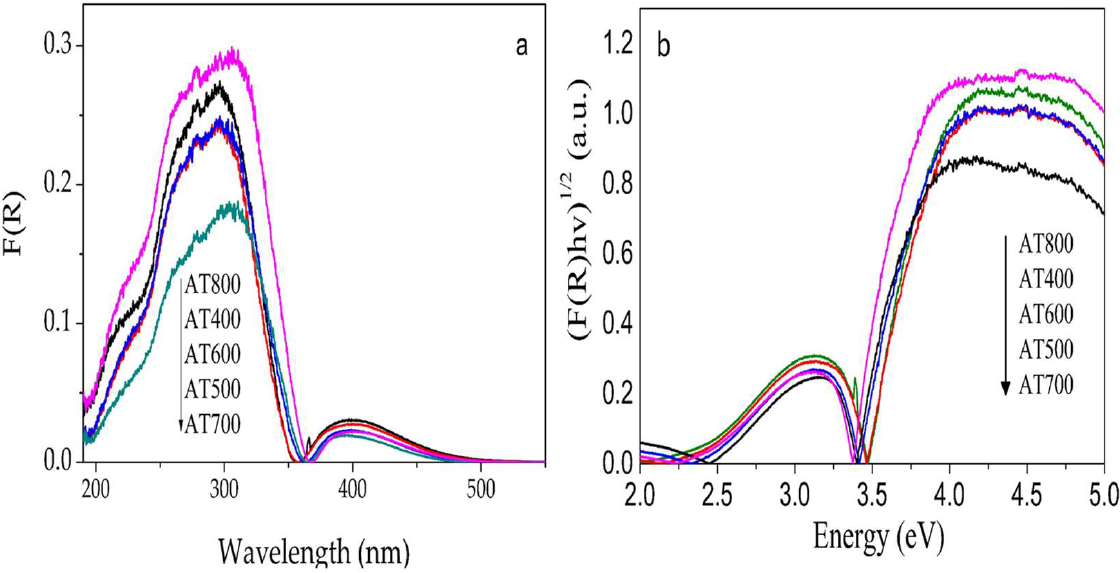
Figure 3. UV-vis diffuse reflectance spectra ( a ) and Tauc plot ( b ) for the AT series calcined at different temperatures. Table 2. Band gap energy (Eg), half time, and apparent first-order reaction constant for the AT se- ries.